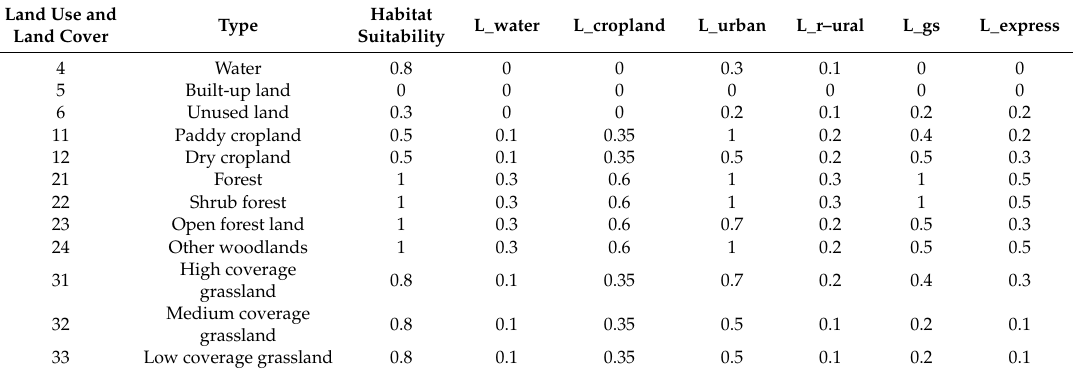
Table 1. The sensitivity of land use type to habitat threat